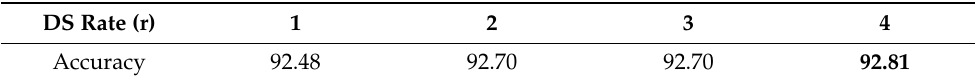
Table 4. The effect of different sampling rates on the classification results. Bold values indicate best performance.